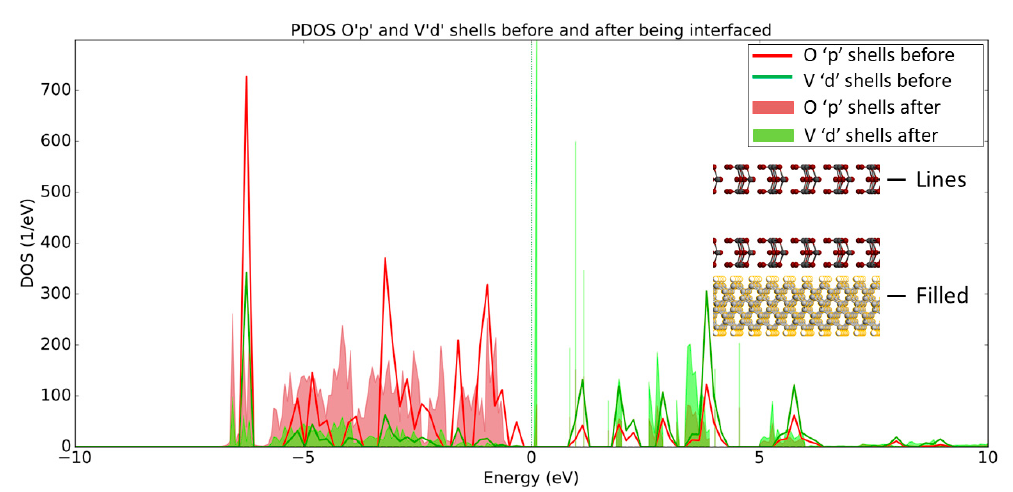
Figure 11. Side view of the V 2 O 5 :H-diamond interface structure showing the electron density differences. The purple regions represent electron accumulation and the green regions represent electron depletion (hole accumulation). The isosurface values are ±0.0025 Bohr − 3 .